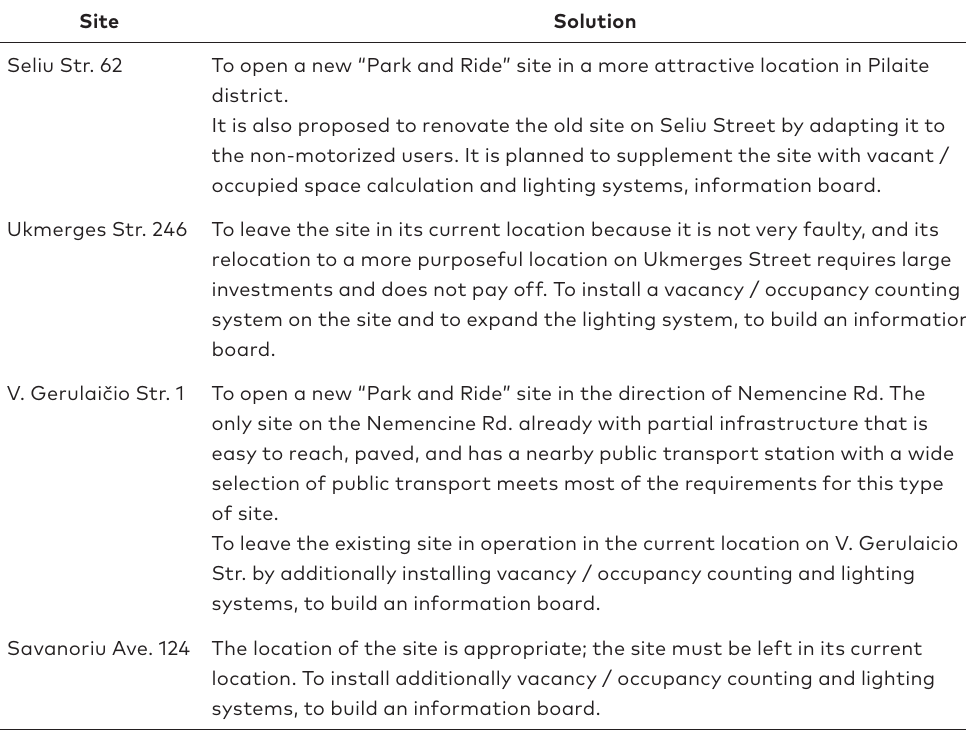
sites (created by the authors)